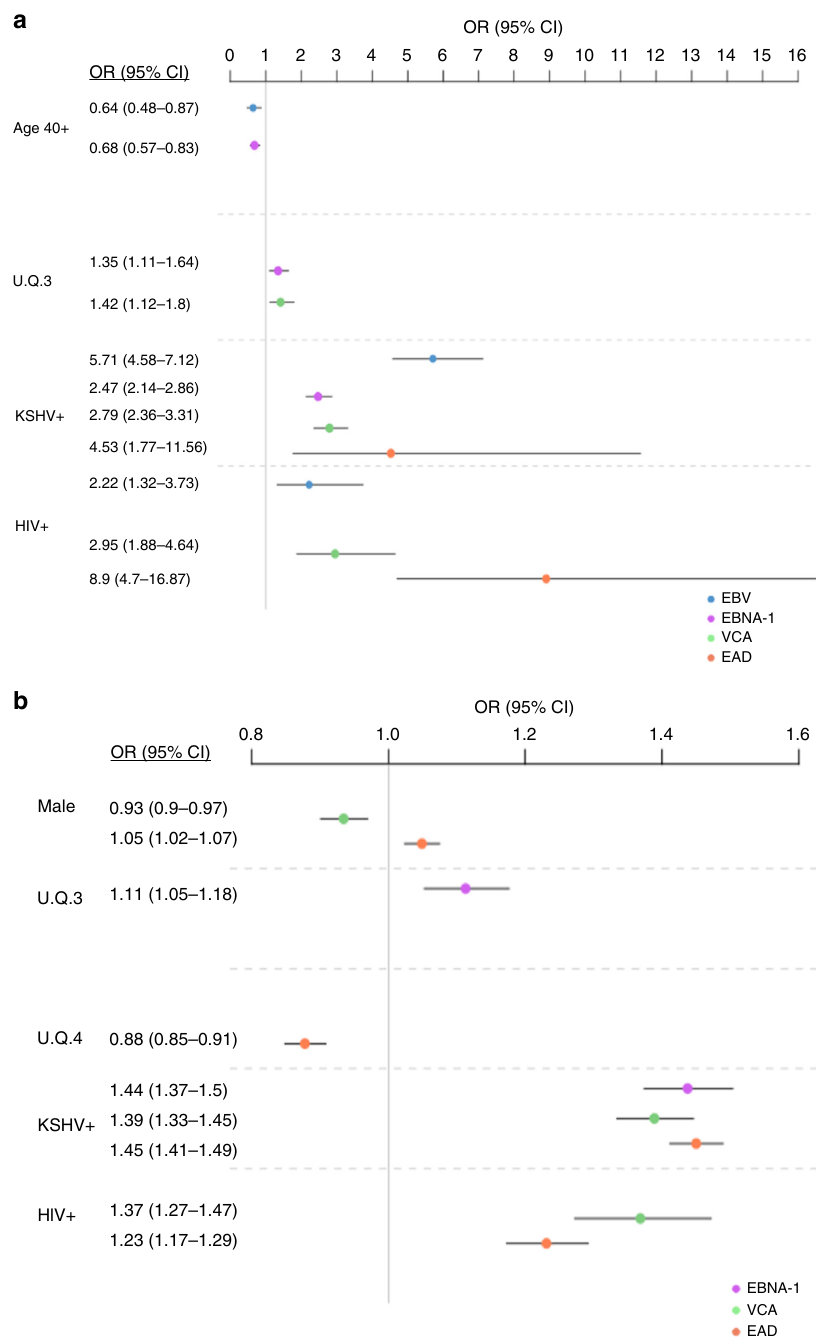
Fig. 3 Predictors of EBV IgG antibody response. Odds ratios (ORs) and 95% con fi dence intervals (CI) of signi fi cant associations ( p < 0.006) between factors and IgG variable as determined based on serologies in the 4365 individuals from the GPC. a Predictors of IgG serostatus. ORs and 95% CI were estimated following a multivariable logistic regression analysis with serostatus (seropositive vs seronegative) as response variable. b Predictors of IgG response level. ORs and 95% CI were estimated following a multivariable linear regression analysis with log 10 -transformed MFI levels as response variable. UQ urbanicity quartile. Dots represent the ORs and are coloured by IgG variable (EBV (seropositivity to EBNA-1 or VCA) — blue, EBNA-1 — magenta, VCA — light green, EAD — orange), lines represent the 95% con fi dence intervals. Full results from this analysis are provided in Supplementary Data